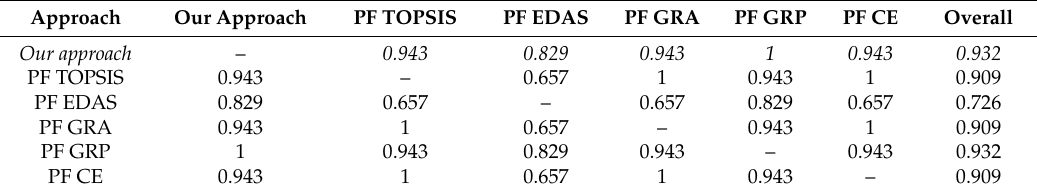
Table 13. The ranking similarity of the compared picture fuzzy